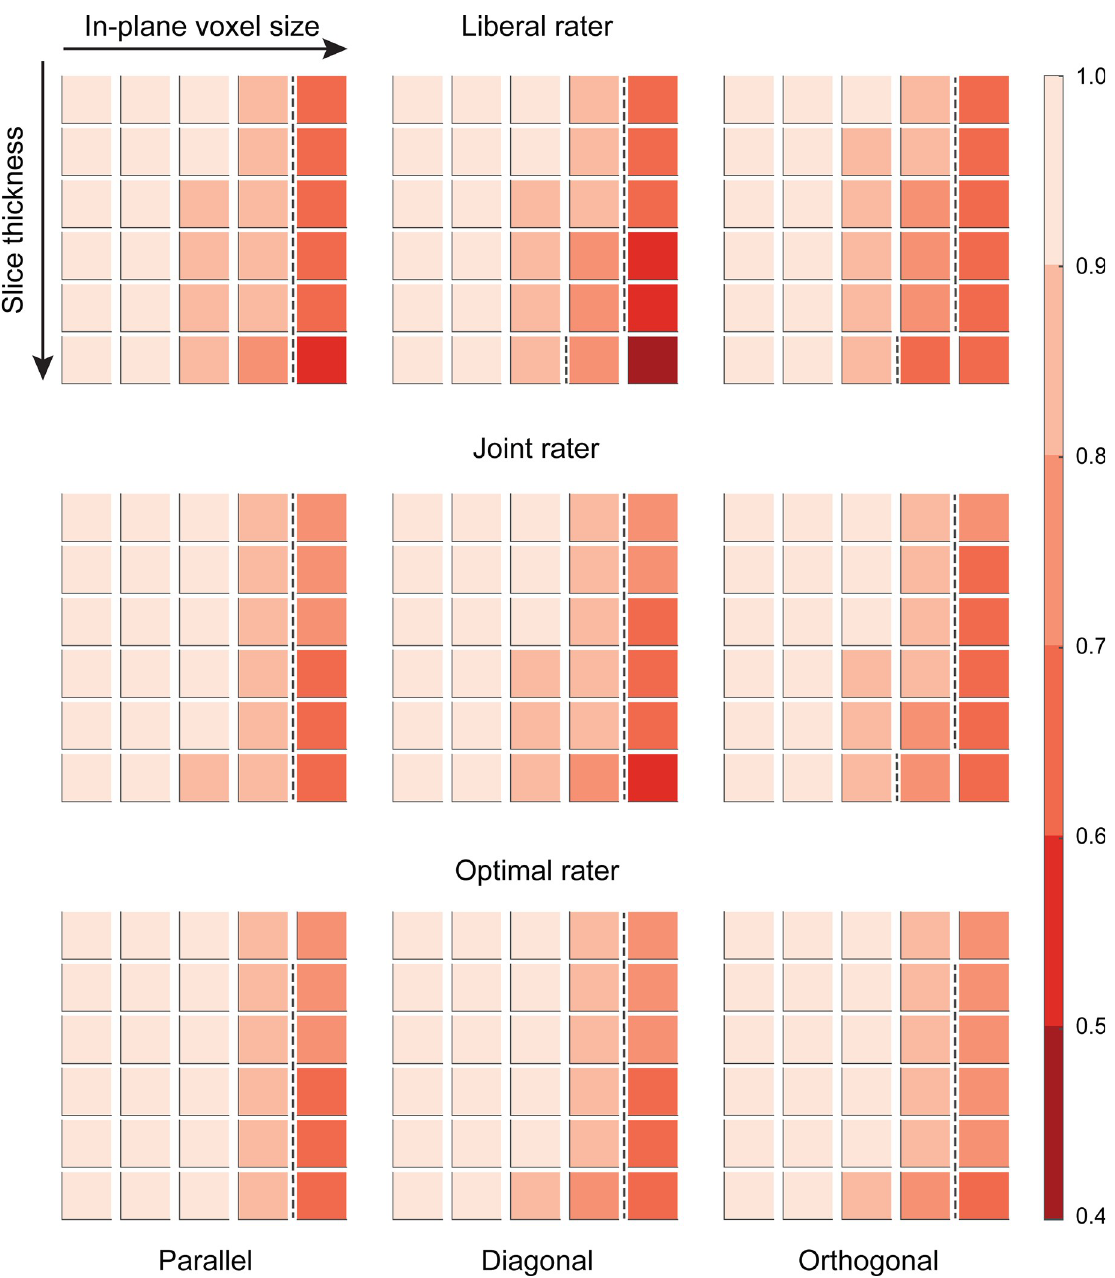
Fig 5. Overview of average shape similarity between the simulated ellipsoids and a high-resolution reference ellipsoid of 0.1 x 0.1 x 0.1mm. Volumes (n = 100) by all three raters were up-sampled to the reference resolution to create a conjunct mask between the reference volume and the labeled volume. Columns refer to the orientation of the ellipsoid (parallel, diagonal, and orthogonal to the slice axis). Each block of squares represents sizes and shapes as depicted in Fig 2, with increasing in-plane resolution (0.1 to 2.0mm) from left to the right, and increasing anisotropy (1x to 3x the in-plane voxel size) from top to bottom, with each top row being isotropic. Color intensity indicates the average shape similarity expressed in DCS. Blocks to the right of the dotted line represent DCS scores <